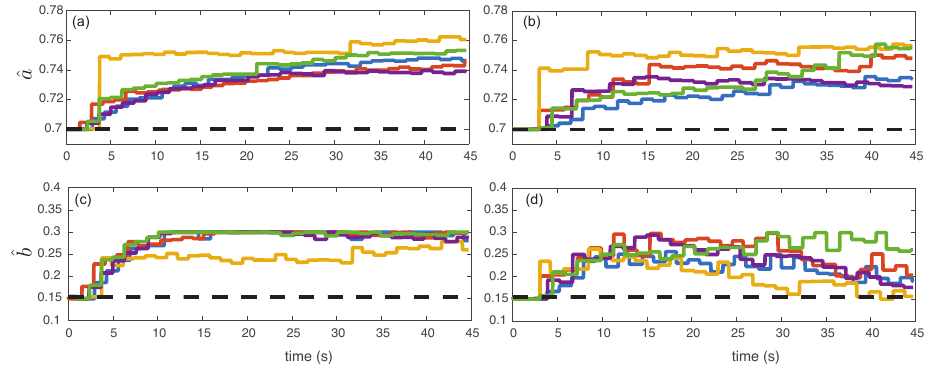
Figure 8. The control parameters as a function of time. ( a , c ) show parameters for added mass of 0.3 kg and ( b , d ) show parameters for added mass of 0.5 kg. The solid lines show the adaptive control parameters, where each line corresponds to a trial, and the dashed lines show the parameters for the non-adaptive